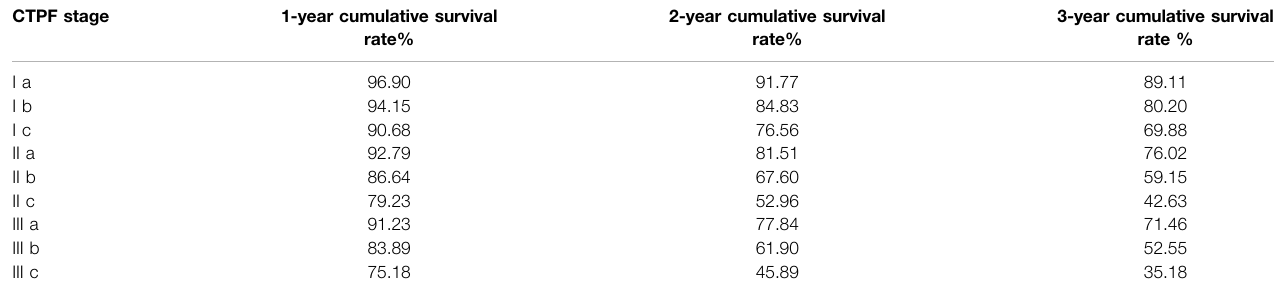
TABLE 6 | CTPF model-predicted 1-, 2-, and 3-year accumulative survive rate of patients at different CTPF stage.